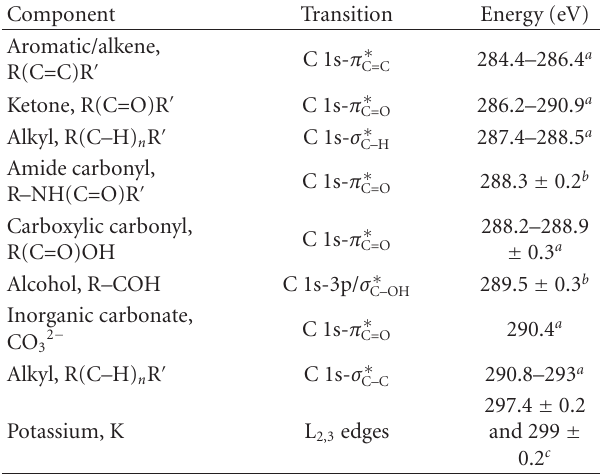
Table 2: Summary of observed marine particle types in southeast Pacific and Arctic